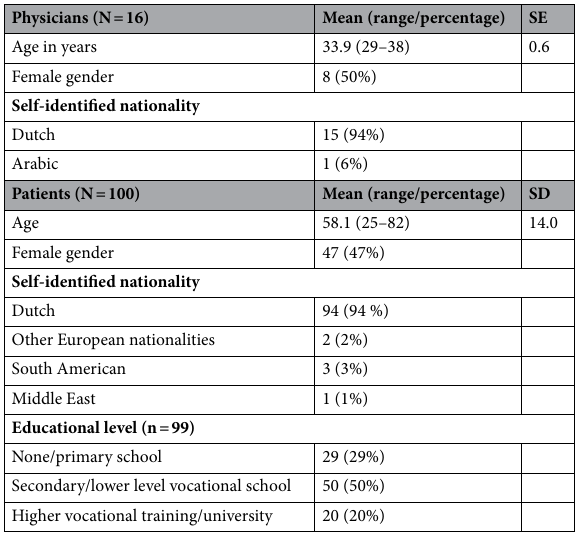
Table 1. Sociodemographic characteristics of physicians and patients.